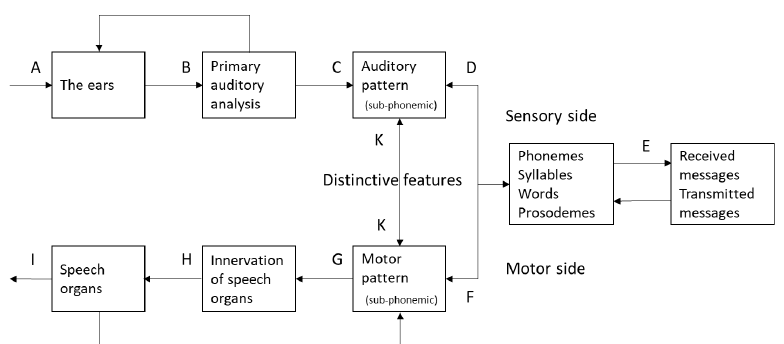
Figure 1. Hypothetical model of brain functions in speech perception and production (adapted from Fant, 1967 [53]).